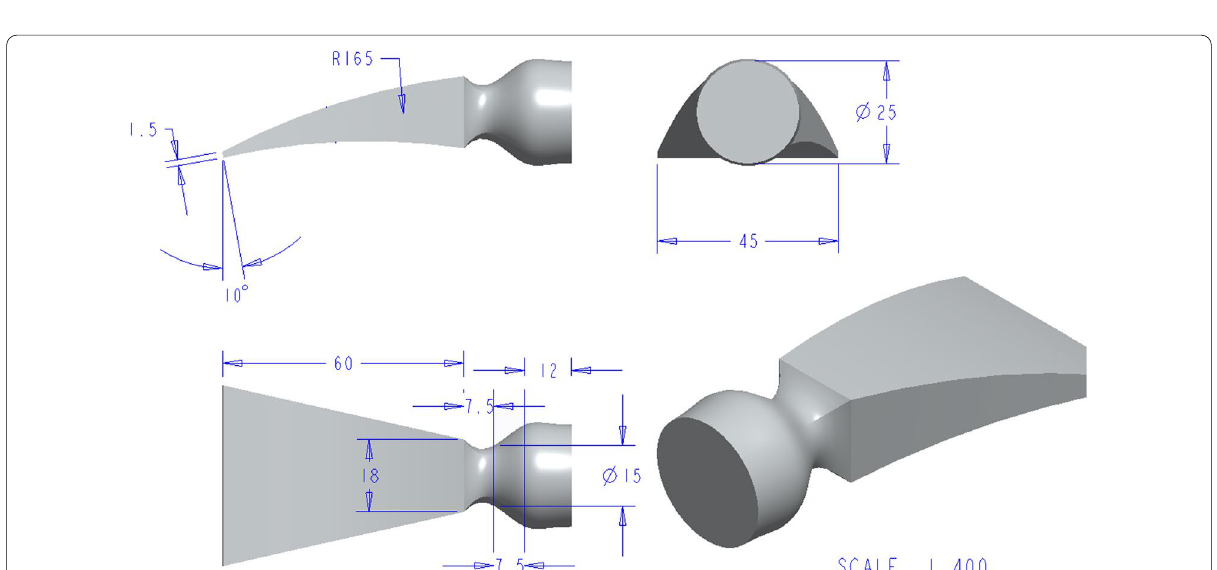
Fig. 17 Detailed drawing of original 3D CAD solid mode shows the CAD for a complex shape in solid modeling representation, designed using PTC Creo Parametric CAD software as case study no.